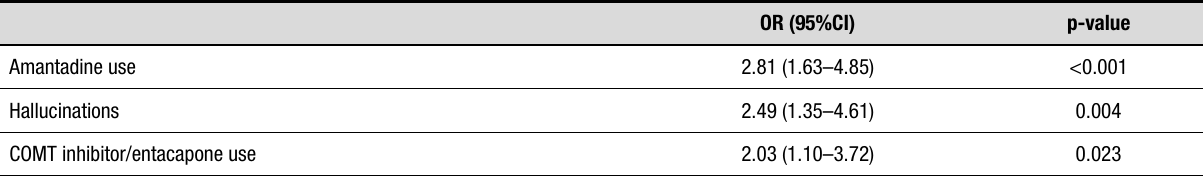
Table 3. Multivariate logistic regression